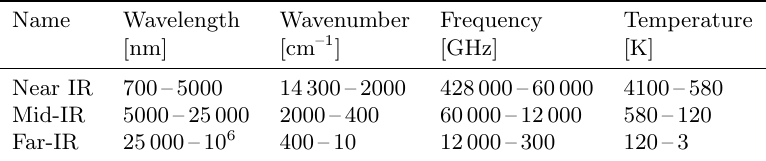
Table 1: Informal Infrared